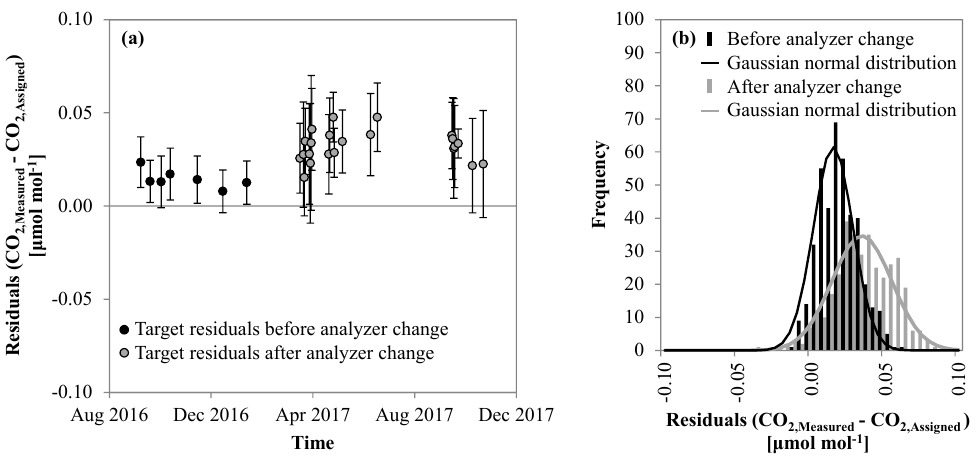
Figure 4. (a) Average of the difference of the target gas measurement minus the assigned CO 2 mole fraction for each run against time; black indicates the measurements before the analyzer change and grey after the analyzer change in March 2017. The error bars correspond to the standard deviation of the individual target gas measurements within each run. (b) Histogram of the residuals of the target gas measurements; again, black stands for the measurements before and grey after the analyzer